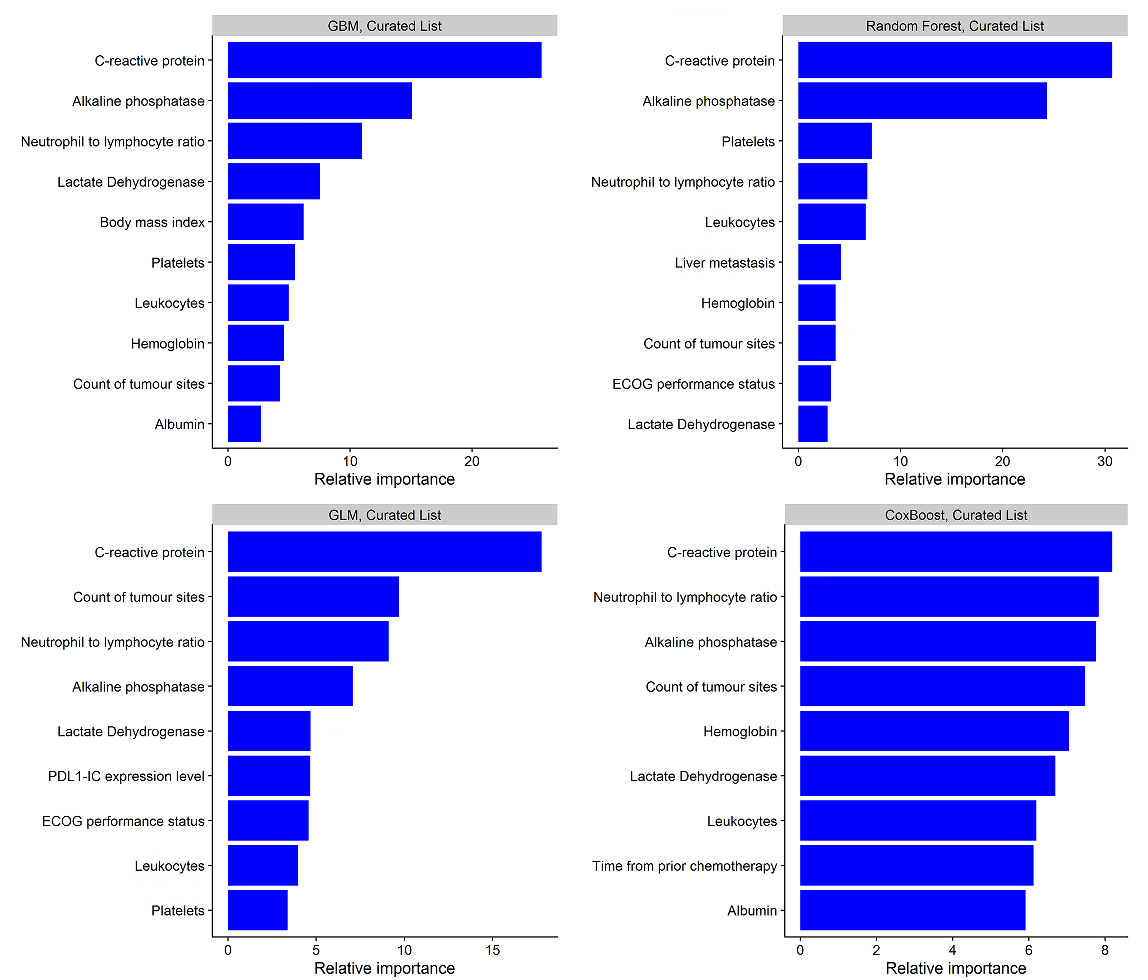
Figure 1. Relative importance of top 10 variables for predicting survival using machine-learning models built with the curated variable list. GLM: generalised linear model with regularisation. ECOG: Eastern Cooperative Oncology Group. PDL-1-IC: Programmed death-ligand 1 gene expression level on immune cells. Table 1. Discrimination performance on validation set for overall survival (OS) and progression-free survival (PFS). OS